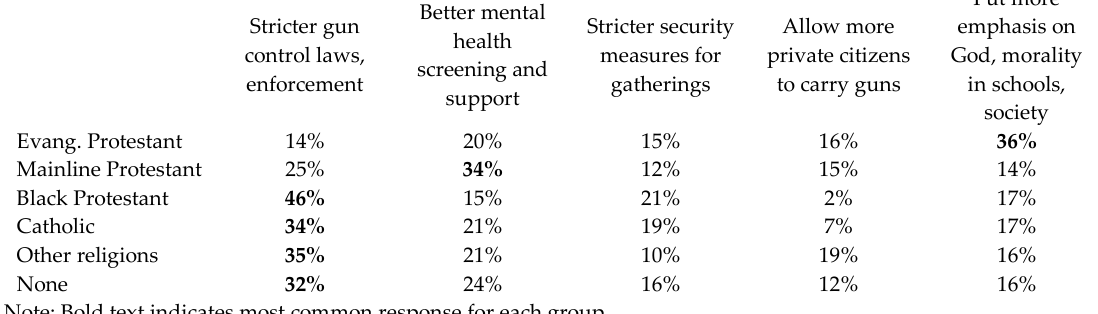
Table 3. “Most important” for preventing mass shootings by religious tradition.